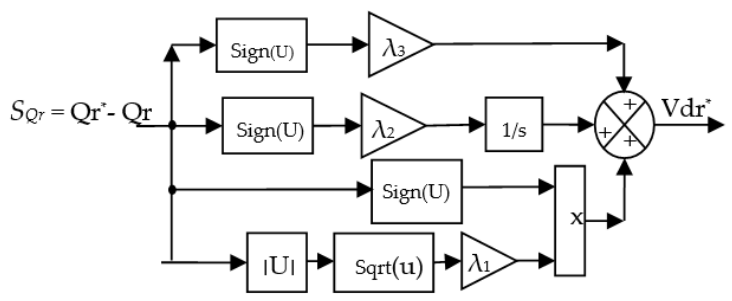
Figure 5. Proposed TOSMC flux controller.